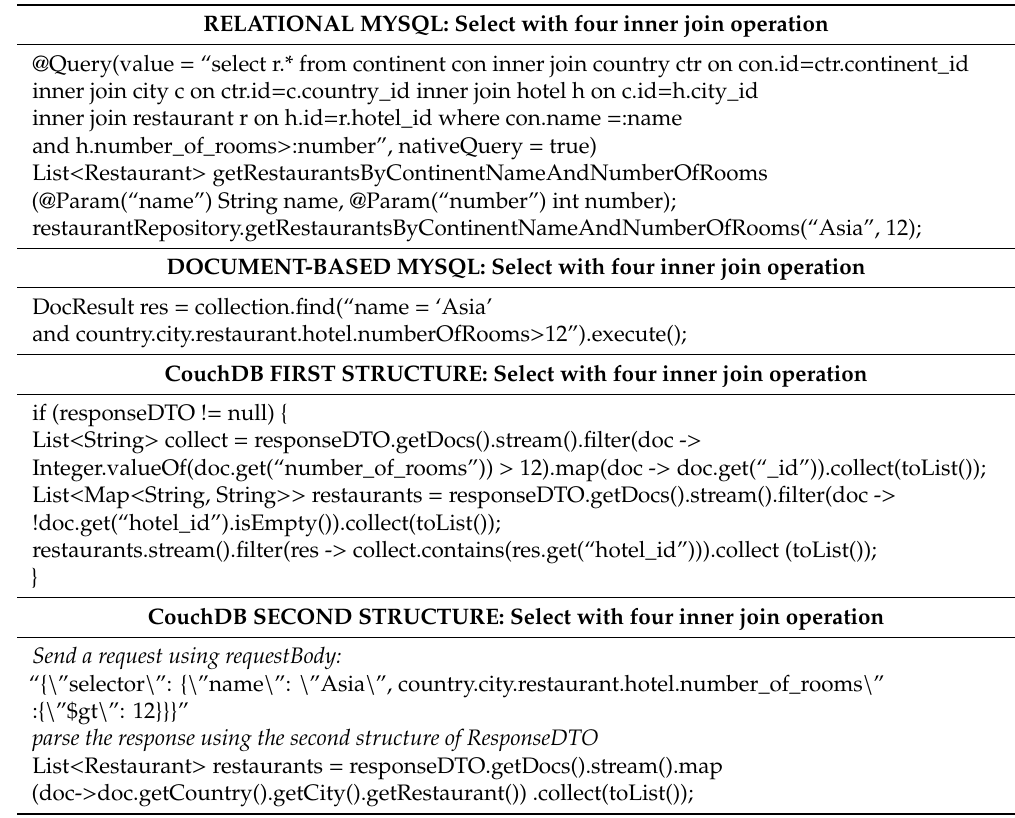
Table 8. Complex select with four inner join